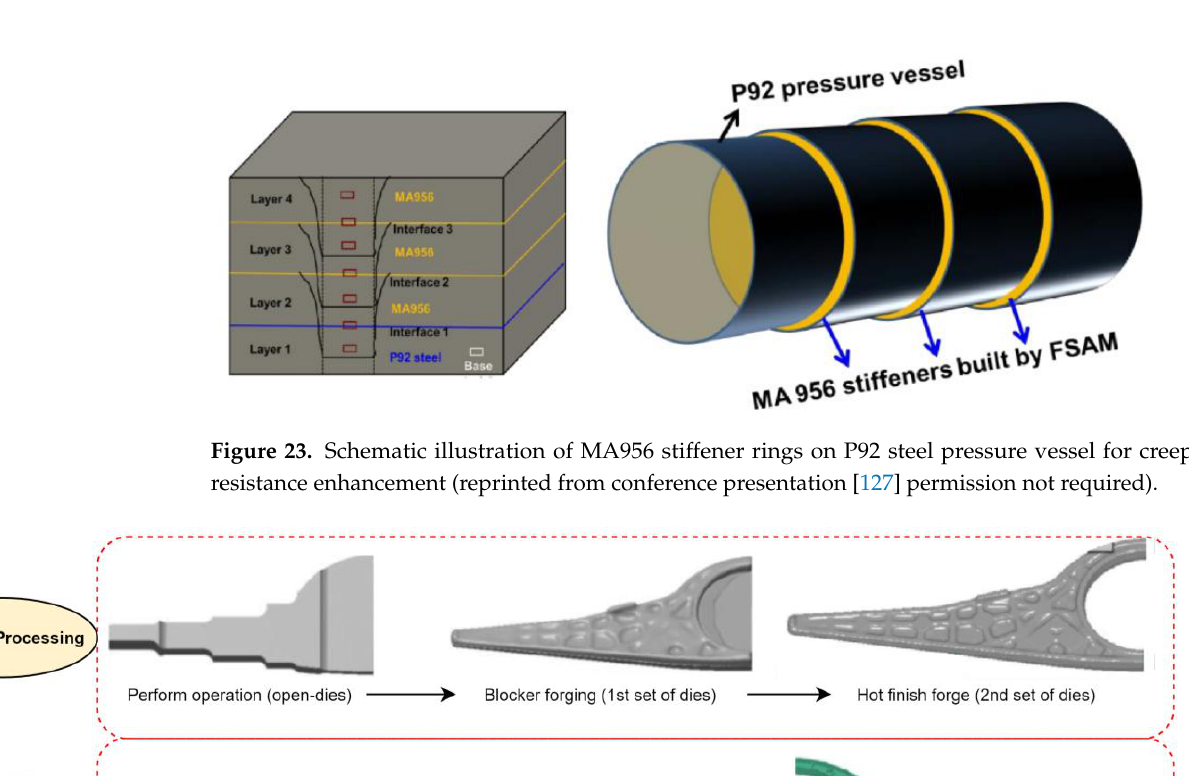
Figure 24. Overview of fictional bulkhead fabrication through existing die forging process fol- lowed by Alcoa corporation.